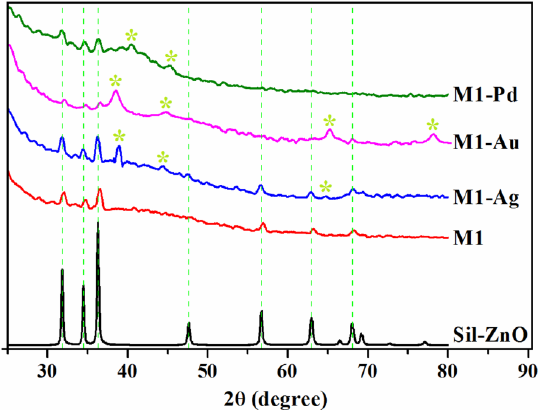
Figure 6. X-ray diffraction (XRD) patterns of Sil-ZnO nanoparticles and of M1, M1-Ag, M1-Au and Figure 6. X-ray di ff raction (XRD) patterns of Sil-ZnO nanoparticles and of M1, M1-Ag, M1-Au and M1-Pd hybrid films (* indicates the diffraction peaks given by noble metal nanoparticles Ag, Au and M1-Pd hybrid films (* indicates the di ff raction peaks given by noble metal nanoparticles Ag, Au and Pd, respectively). Pd,